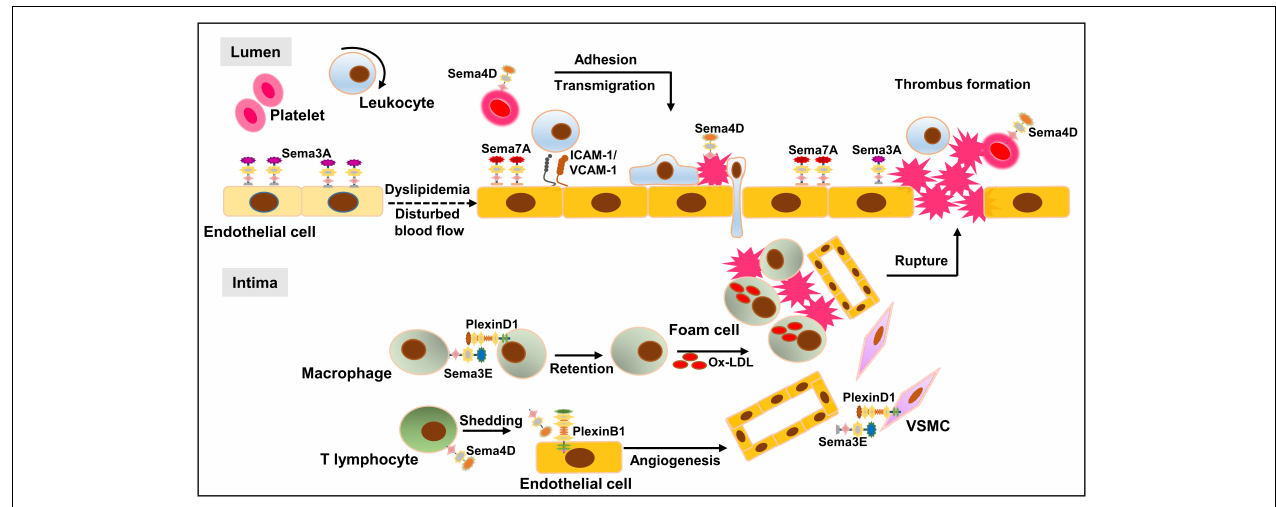
FIGURE 6 | Network regulation of semaphorins in atherosclerosis. When exposed to oxLDL or injured by disturbed blood flow, endothelial cells undergo major phenotypic changes, e.g., upregulation of inflammatory cytokines, leading to leukocyte adhesion and infiltration into the intima wall. Accumulating immune cells including macrophages and T cells fuel the immune response, leading to the transition of a fatty streak to a complex atherosclerotic plaque. Plaque rupture and thrombus formation may lead to fatal cardio-cerebrovascular events. D-flow upregulates endothelial Sema7A and downregulates endothelial Sema3A and VSMC-Sema3E, leading to the infiltration of inflammatory leukocytes and VSMCs. Following cell infiltration and plaque formation, intraplaque Sema4D, shedding from activated T lymphocytes, interacts with PlexinB1 on endothelial cells, resulting in endothelial cell migration and intraplaque angiogenesis. In the advanced plaque, Sema3E interacts with PlexinD1 on macrophages to regulate macrophage emigration. Upon plaque rupture, platelet Sema4D binds leukocytes as well as injured endothelial cells to support thrombus formation, exacerbating the pathological